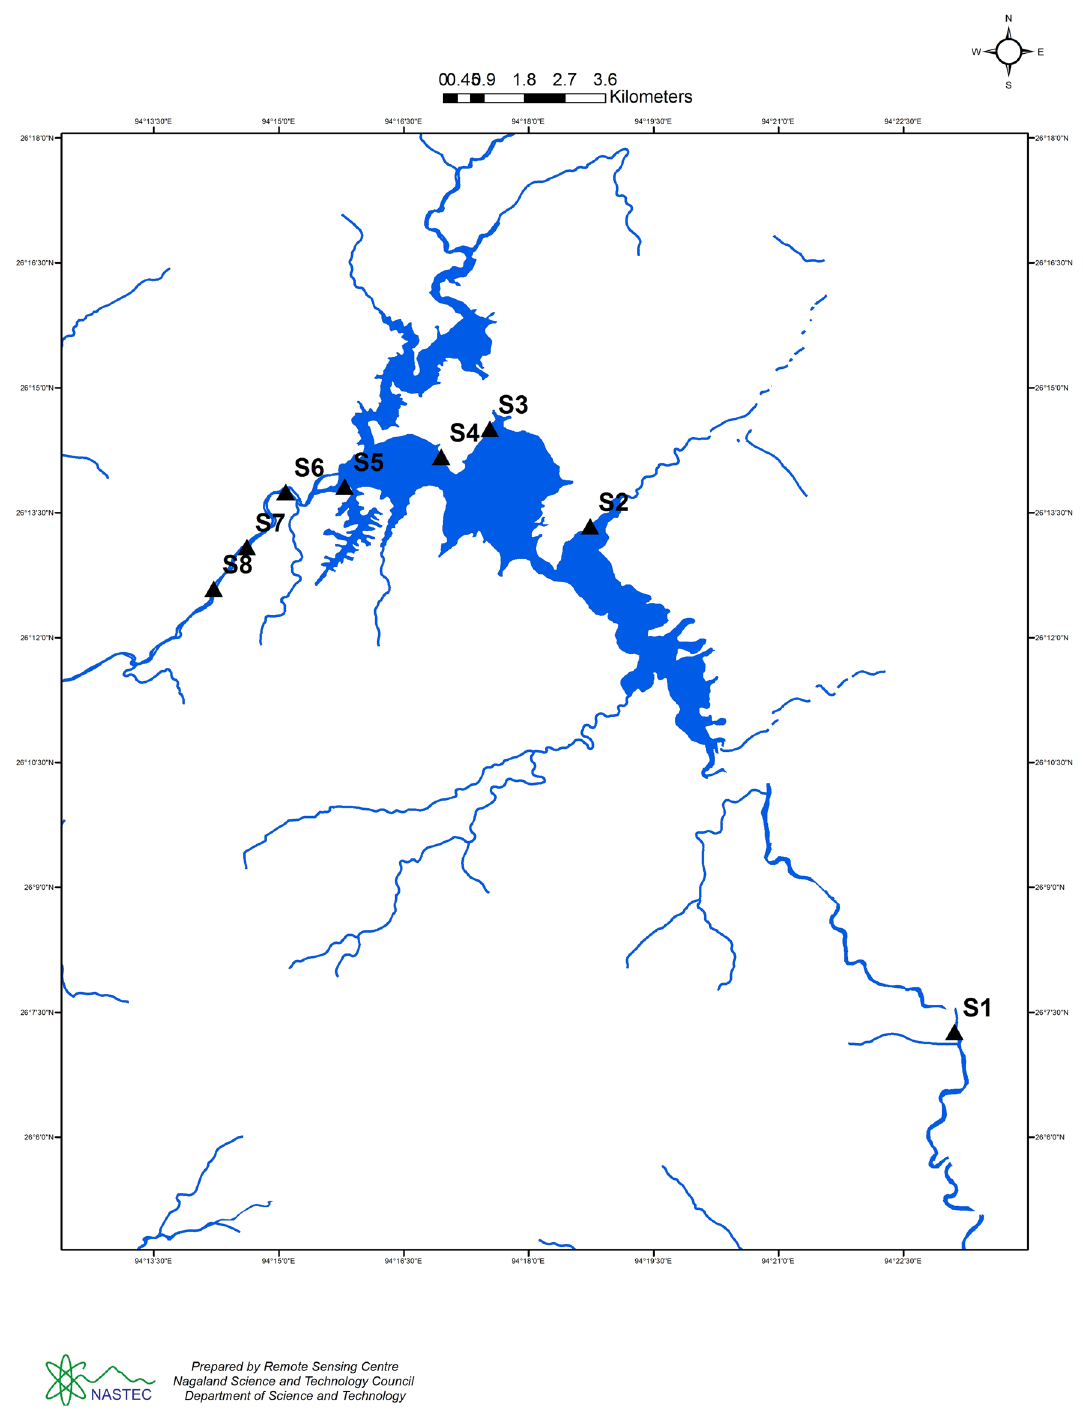
Fig. 2 Map indicating the sampling stations located along Doyang